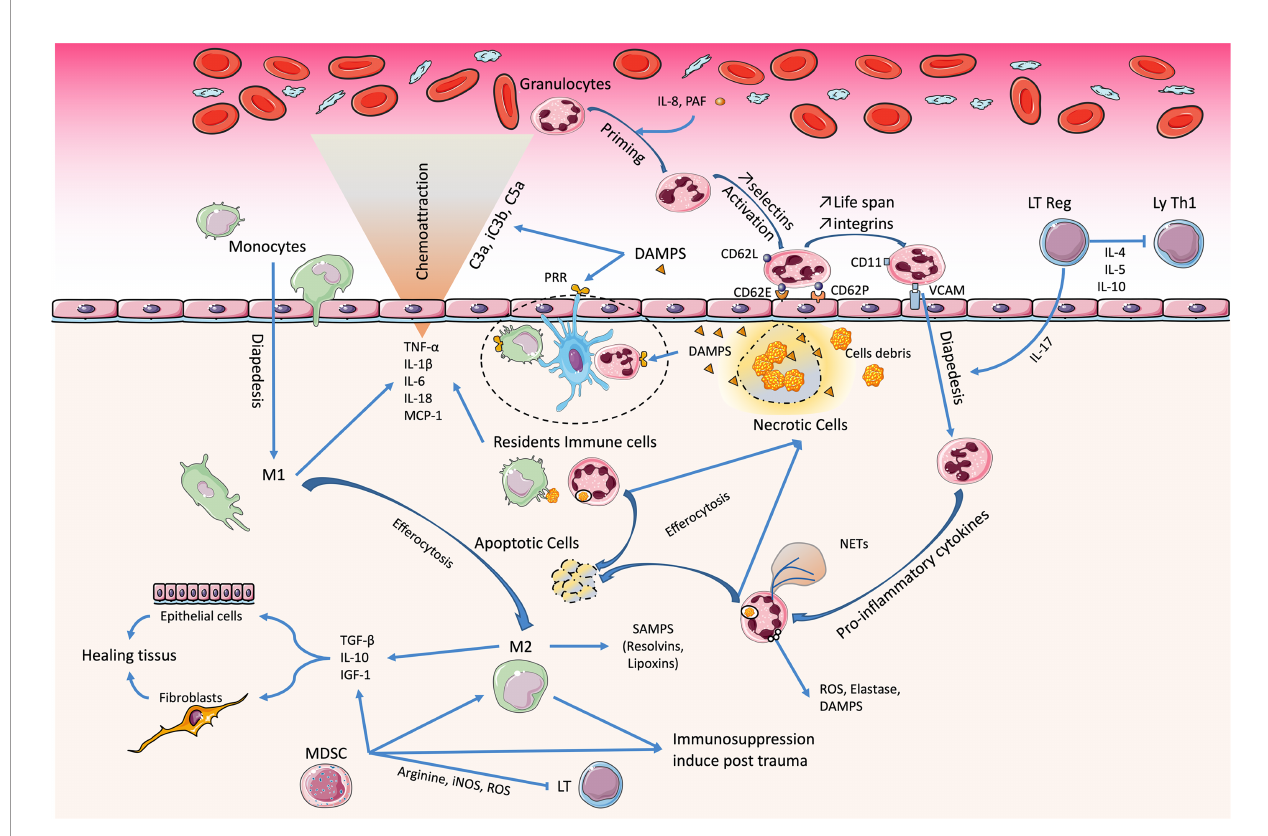
FIGURE 1 | Immunological imbalance during traumatic hemorrhagic shock (THS). Damage-associated molecular patterns (DAMPs) play a key role in pathophysiology. The resident immune cells detect them and carry out the fi rst reactions of phagocytosis and ampli fi cation of the in fl ammatory response. The circulating granulocytes in fi ltrate the tissue and maintain this reaction. Later-onset macrophages are pivotal in resolving this in fl ammatory phase (M1 ! M2) and initiate the healing phase. However, during THS, the abundance of DAMPs promotes the acquisition and maintenance of a pro-in fl ammatory phenotype. The trio of Treg, platelets, and endothelial cells co-stimulates and causes immunomodulation, with inhibition of Th1 lymphocytes. Bone marrow dysfunction induces an immunosuppression that favors the occurrence of